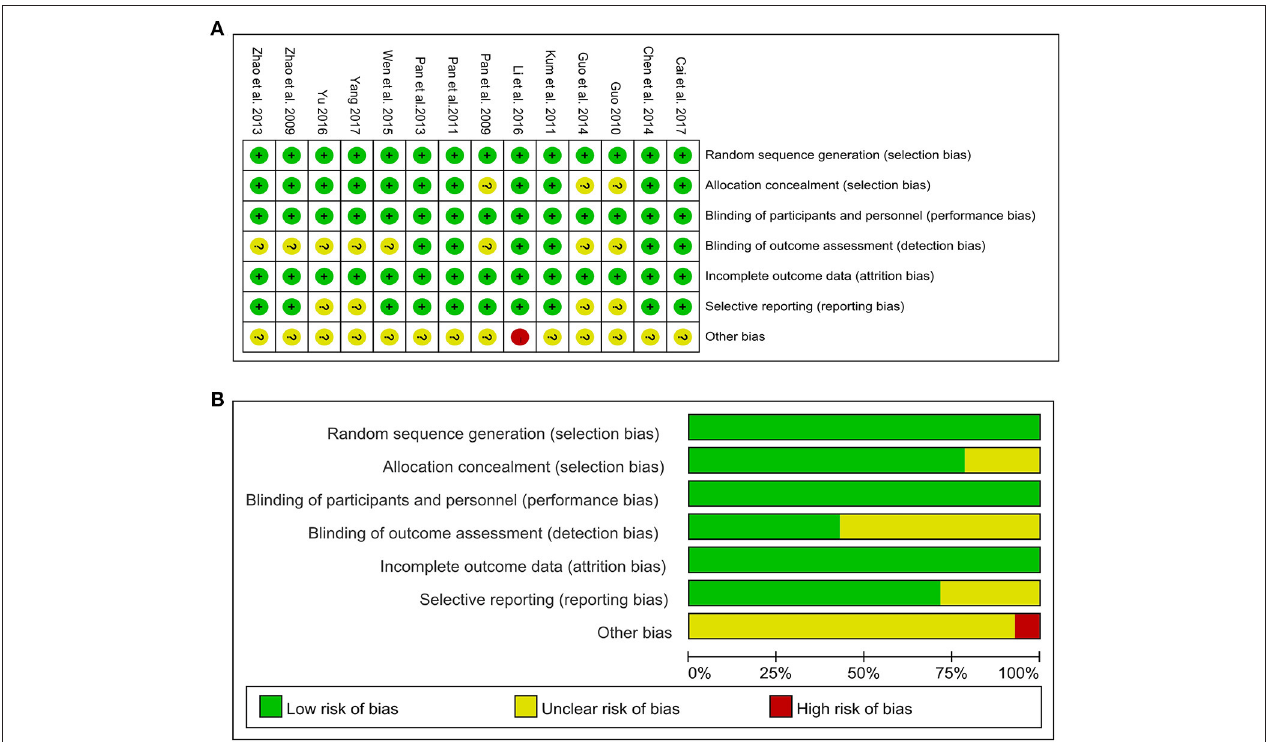
FIGURE 2 | Risk of bias of the included studies. (A) Risk of bias summary: judgements about each risk of bias item for each included study. (B) Risk of bias graph: judgements about each risk of bias item presented as percentages across all included studies. + , low risk of bias; -, high risk of bias; ?, unclear risk of